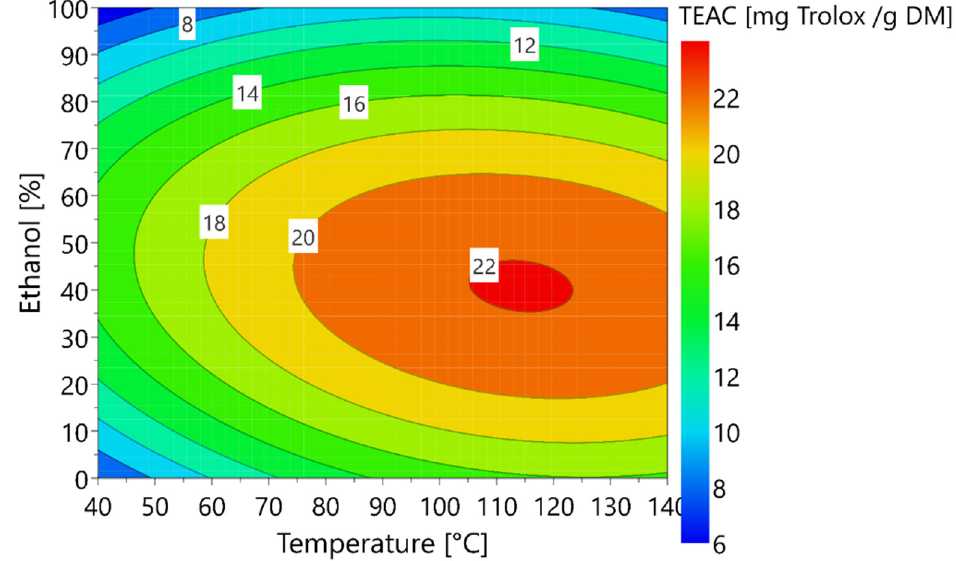
Figure 4. Response surface plot of the TEAC of the extracts. Figure 4 . Response surface plot of the TEAC of the extracts .